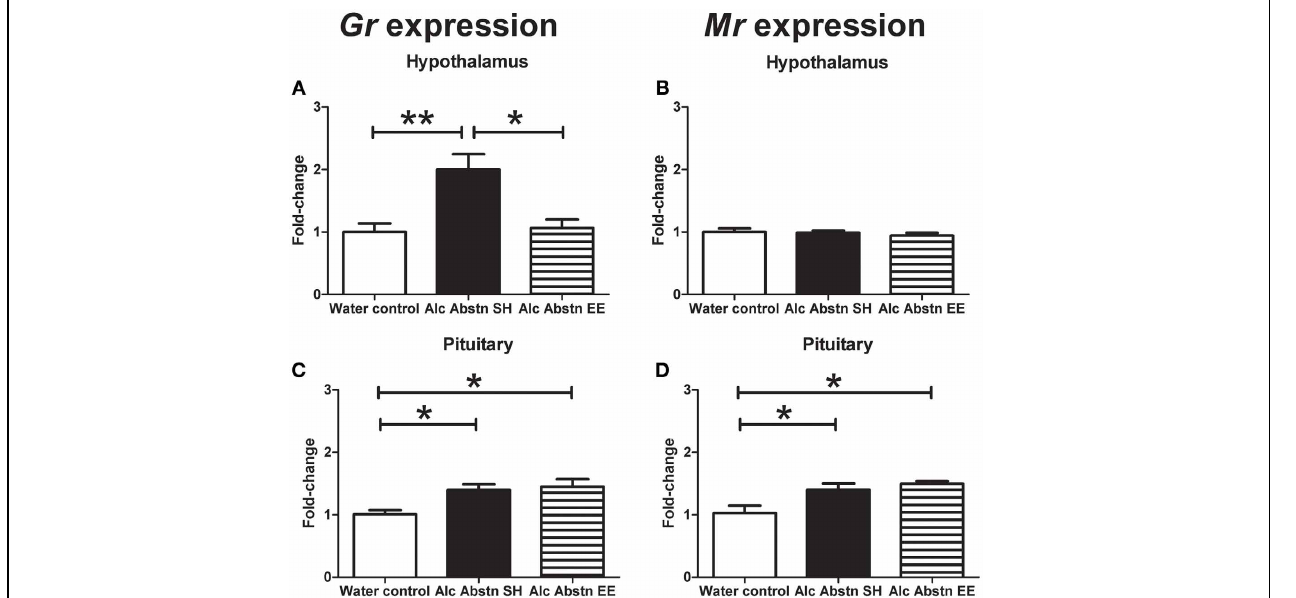
FIGURE 4 | Differential effects of environmental enrichment on steroid hormone receptors. (A) An up-regulation of GR expression in the hypothalamus of Alc Abstn mice is not observed in the group exposed to enrichment. (B) No observable change to hypothalamic MR expression. (C) Up-regulation of pituitary GR expression in Alc Abstn mice is maintained in the enriched group. (D) In contrast to